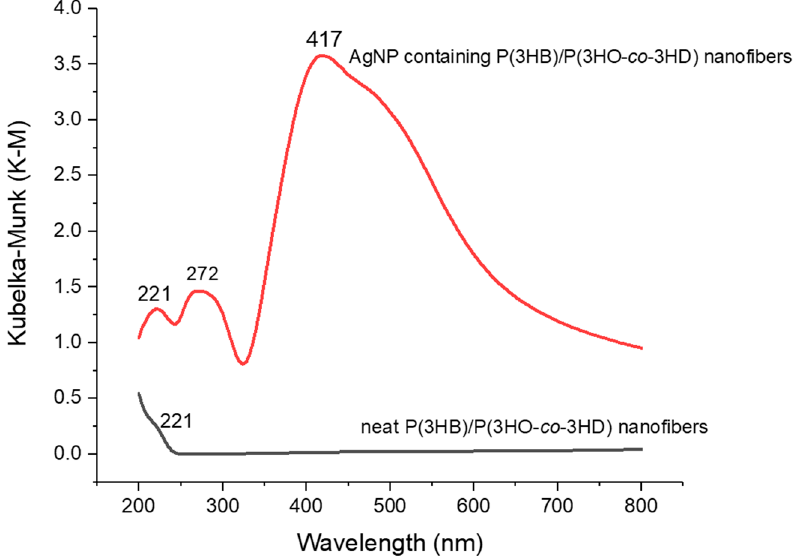
Figure 6. UV-Visible spectroscopy of neat P(3HB)/P(3HO- co -3HD) nanofibers (red) and AgNP containing P(3HB)/P(3HO- co -3HD) nanofibers (black). P(3HB)/P(3HO- co -3HD) nanofibers with AgNPs show a strong absorbance peak at 417 nm pointing out the AgNPs existence; however, neat P(3HB)/P(3HO- co -3HD) nanofibers do not show any peaks between 250 and 600 nm. The biological activity of the AgNP-containing nanofibers was further